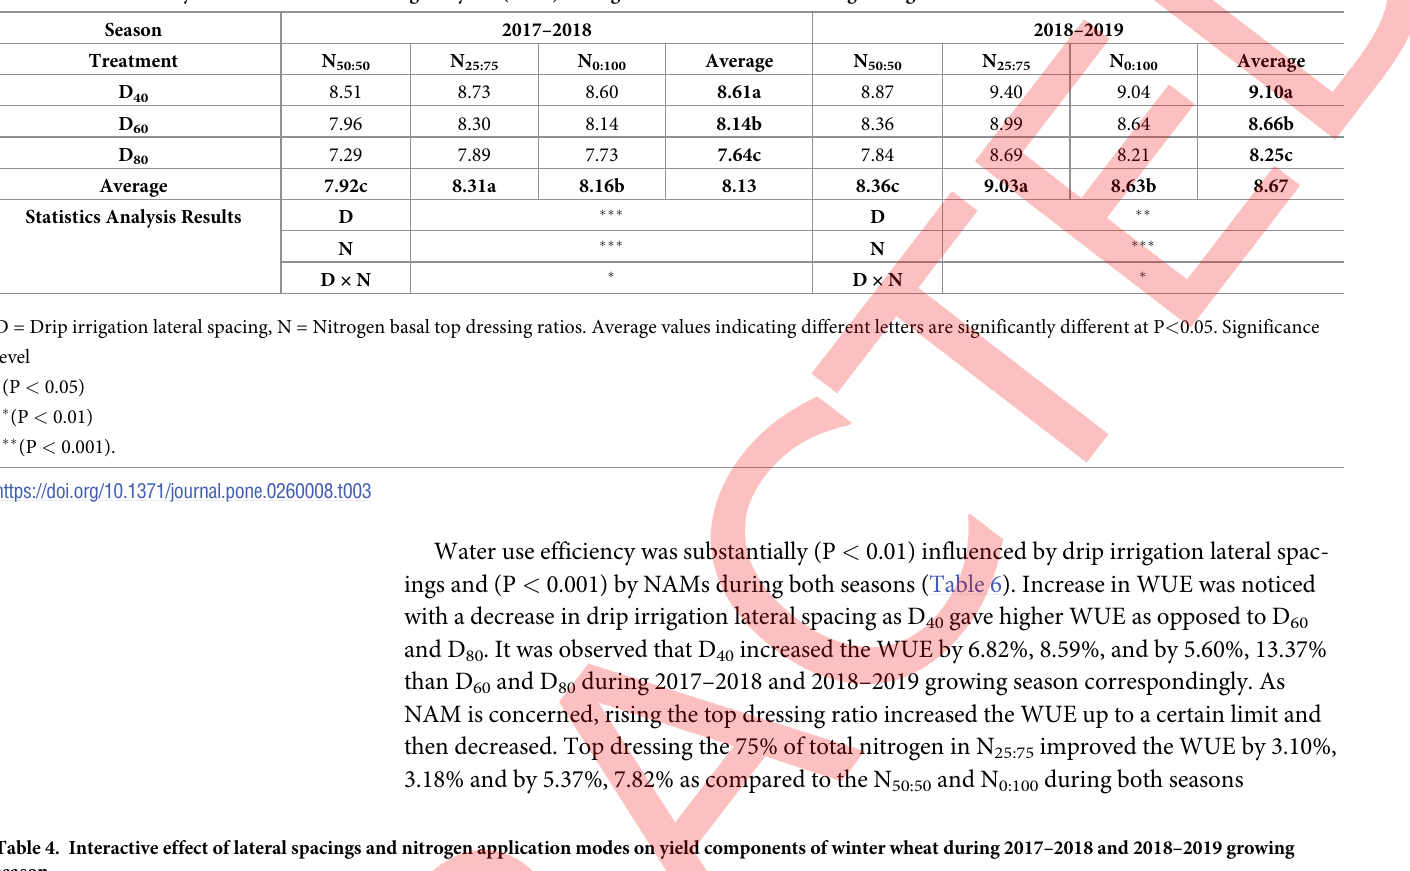
Table 4. Interactive effect of lateral spacings and nitrogen application modes on yield components of winter wheat during 2017–2018 and 2018–2019 growing season. Season Treatment